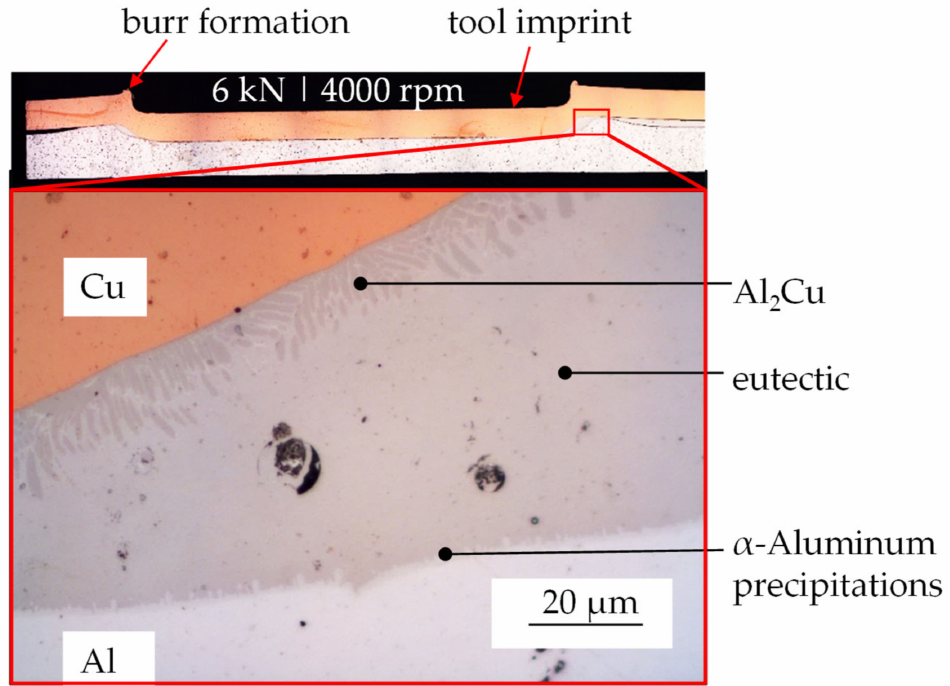
Figure 8. Microsection of a weld with its typical metallographic constitution exemplary—used tool (Ø10